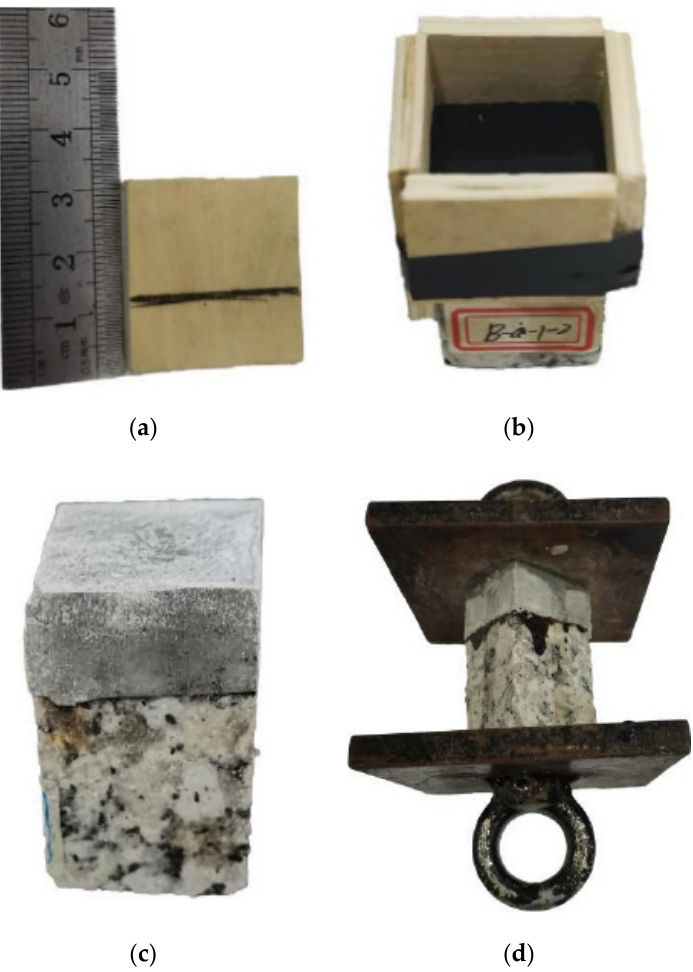
Figure 5. Preparation of the mortar and test specimens. ( a ) Sandwich wood board, ( b ) Granite specimen covered with the mold, ( c ) Test specimen ( d ) Specimen ready for pull-off test.